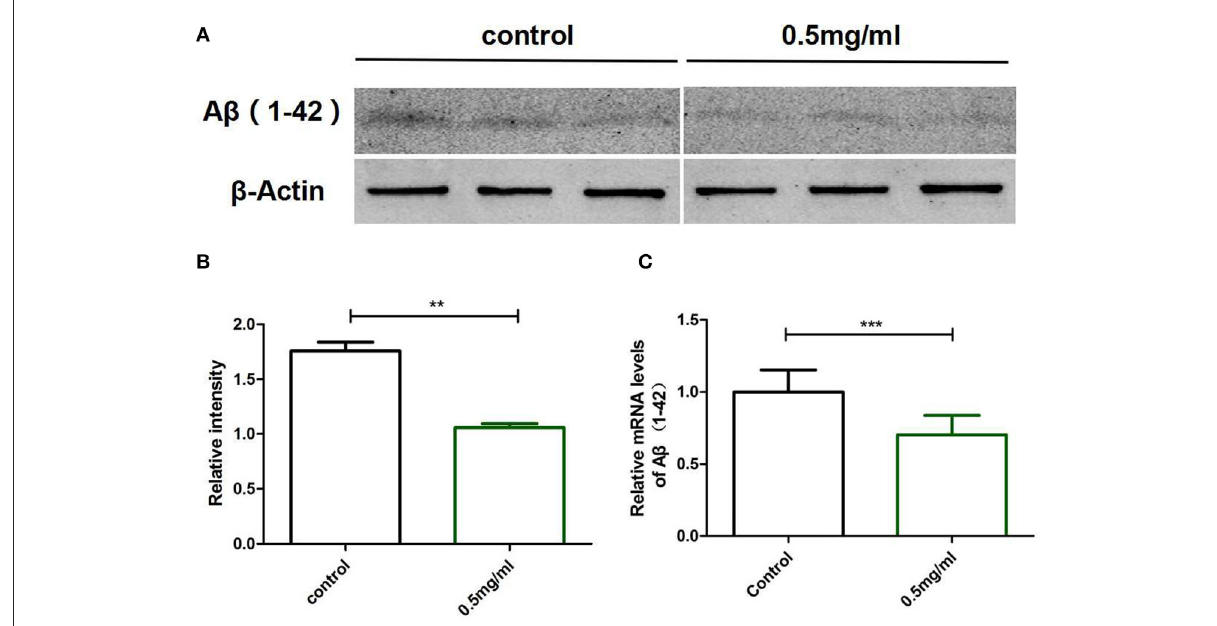
FIGURE4 Exendin-4 attenuated the protein and mRNA levels of A β (1-42) in C. elegans CL4176. (A) Western blotting assays of experiments repeated independently for three times are shown. Control groups were not treated with Exendin-4. The test groups were treated with 0.5 mg/ml of Exendin-4. (B) The relative intensity of A β (1-42) expression was analyzed using the ImageJ software. After treatment with 0.5 mg/ml Exendin-4, the protein expression level was reduced by 39.78%. p < 0.01 ( ** ). (C) The mRNA levels of A β (1-42) were analyzed by real-time PCR. mRNA levels were reduced by 29.67%. p < 0.001 ( ***